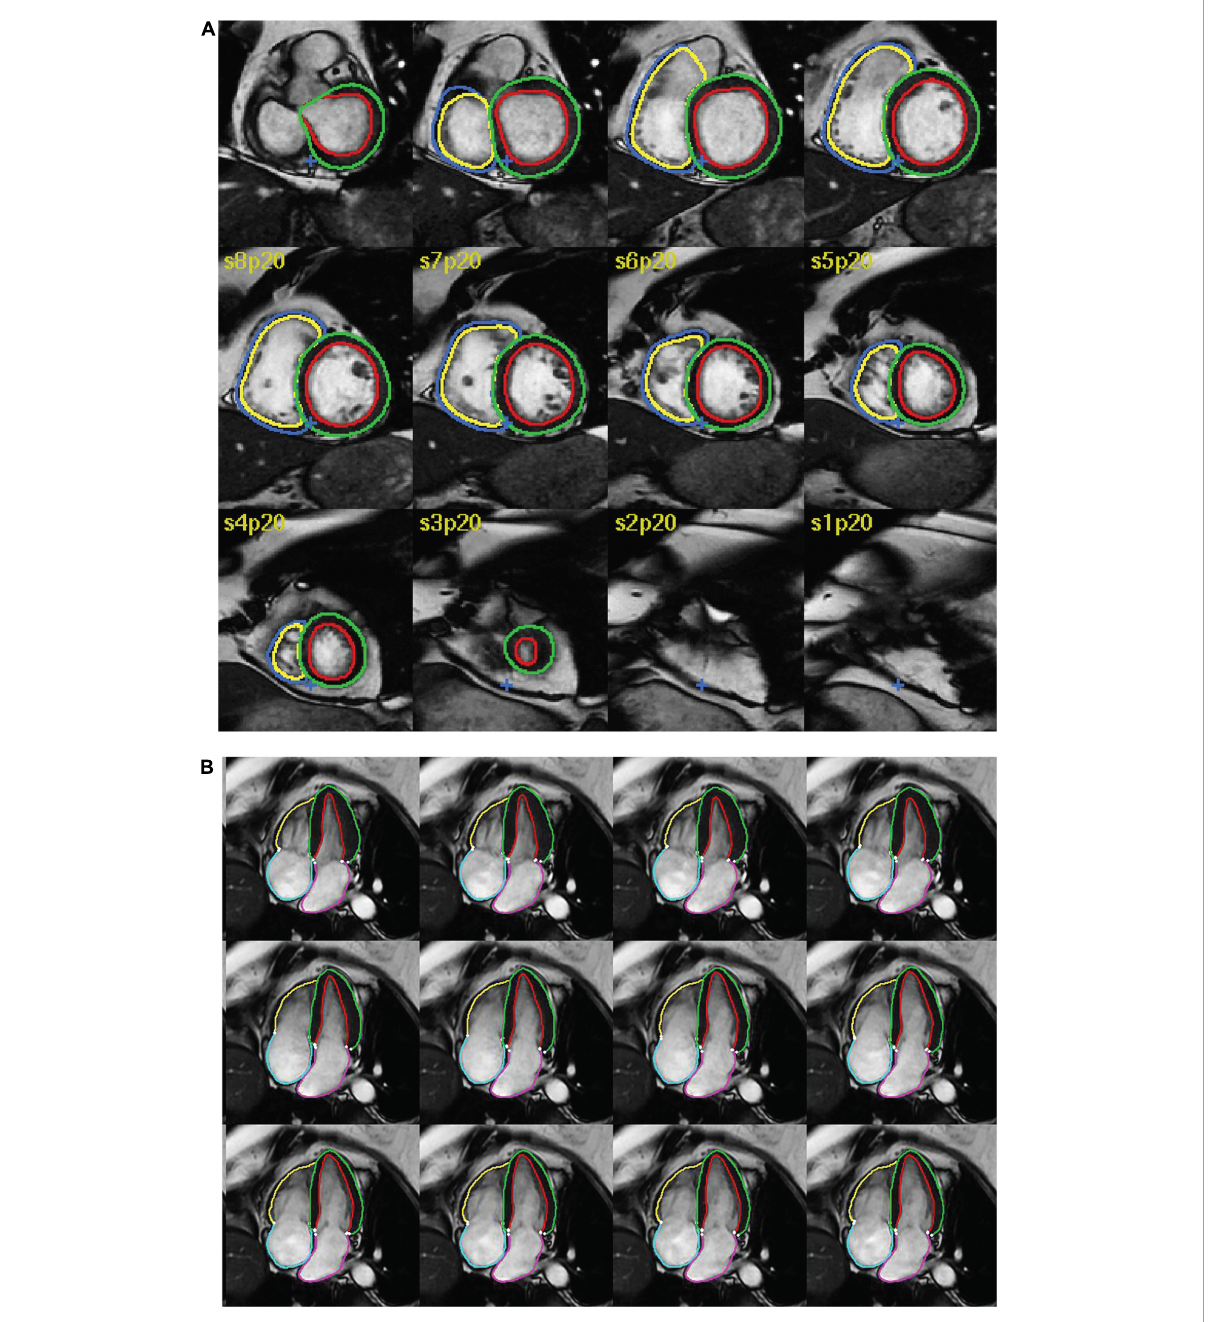
FIGURE1 Examples of AI cardiac MRI segmentation. Examples of automatic (A) biventricular and (B) four-chamber segmentation. The colored contours in green and red show the left ventricular epi- and endocardium, respectively. The contours in dark blue and yellow show the right ventricular epi- and endo- cardium, respectively. The pink and turquoise contours outline the left and right atria, respectively.